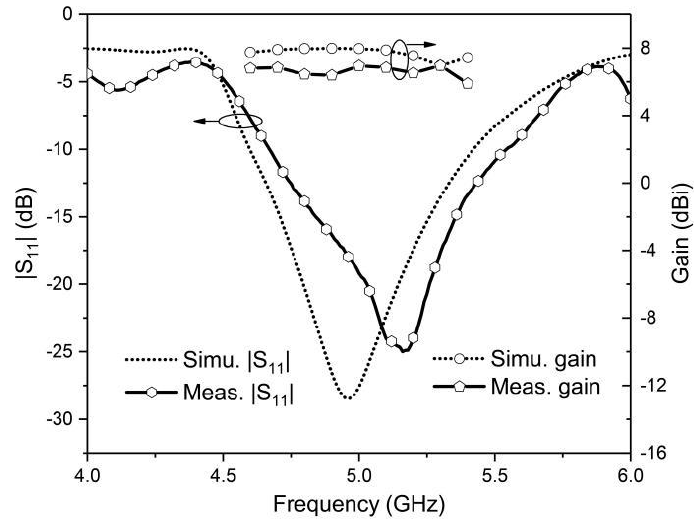
Figure 15. Simulated and measured | S 11 | and gain values of proposed array antenna.